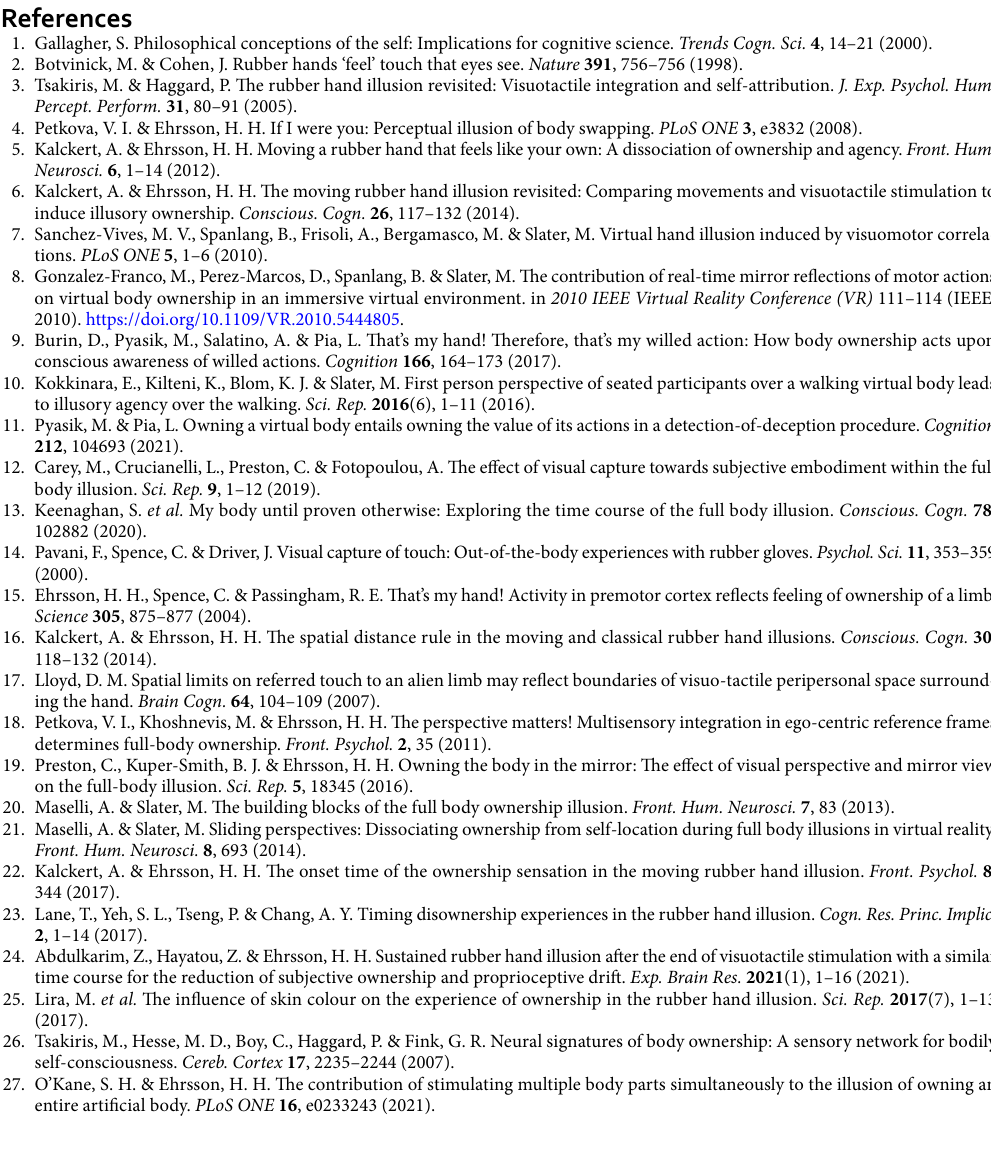
for which the button was pressed was recorded as the duration of each trial. The onset time and duration were measured three times for each condition in random order. In both the questionnaire and measurement sessions, the participants removed the HMD after each trial and moved their physical body for approximately 30 s to eliminate the remaining body ownership. Data availability All data generated or analyzed during this study are included in this published article and Supplementary Data 1.